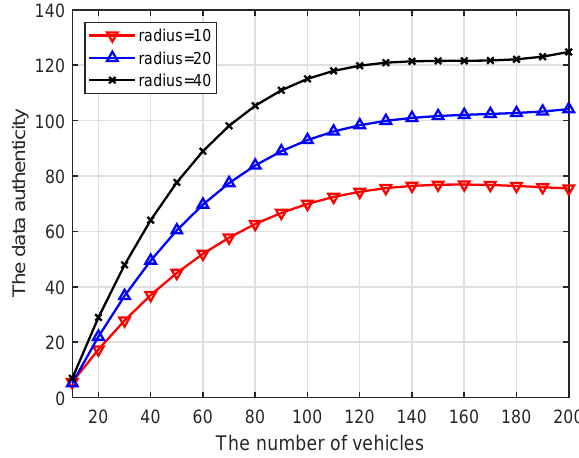
Figure 10. Vehicles vs. Data authenticity.